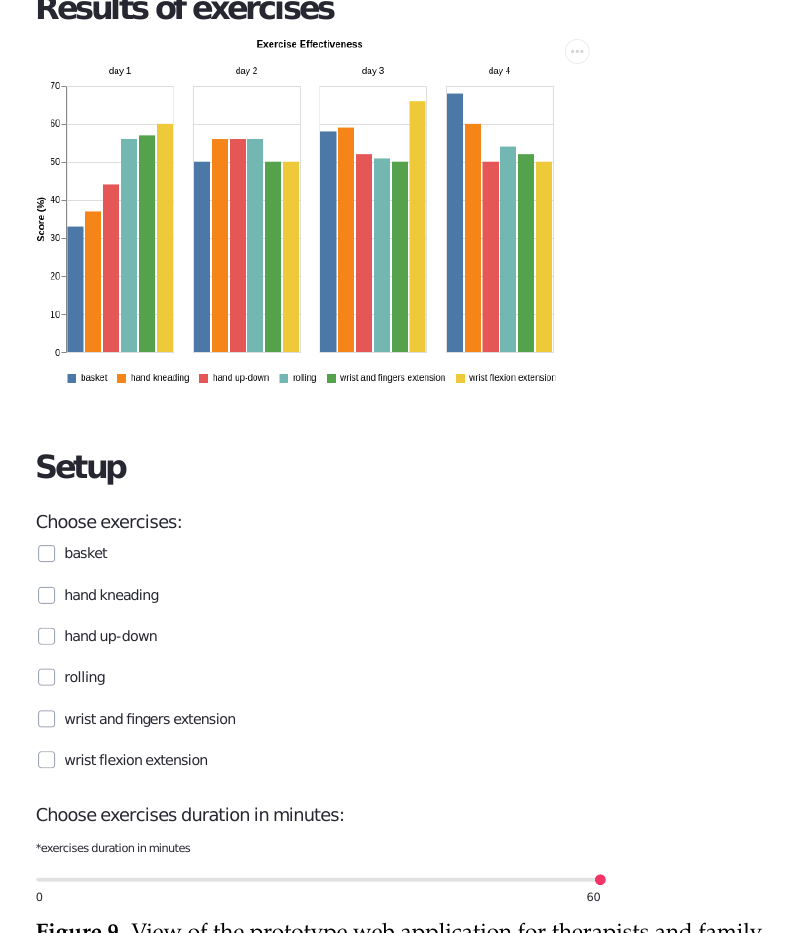
Figure 9. View of the prototype web application for therapists and